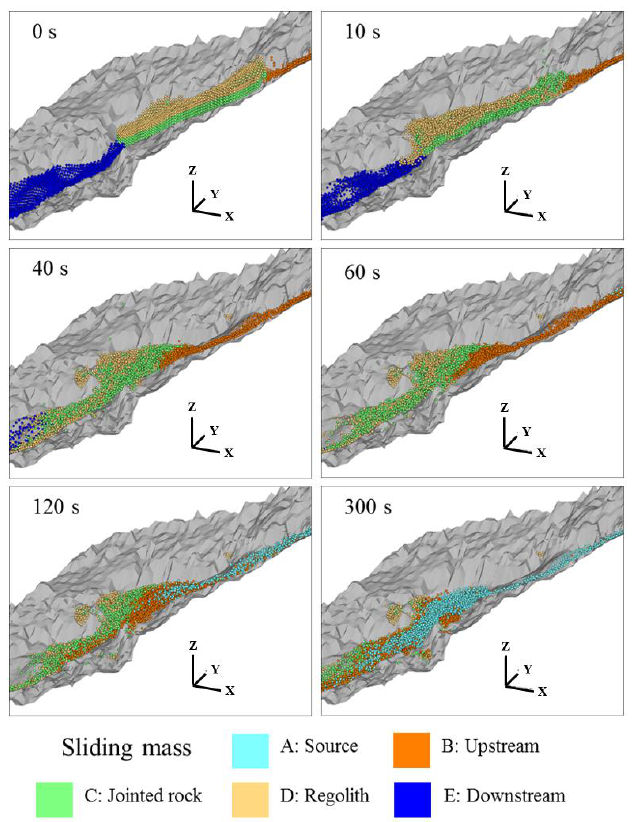
Figure 18. Simulation of the cataclinal slope during landslide.